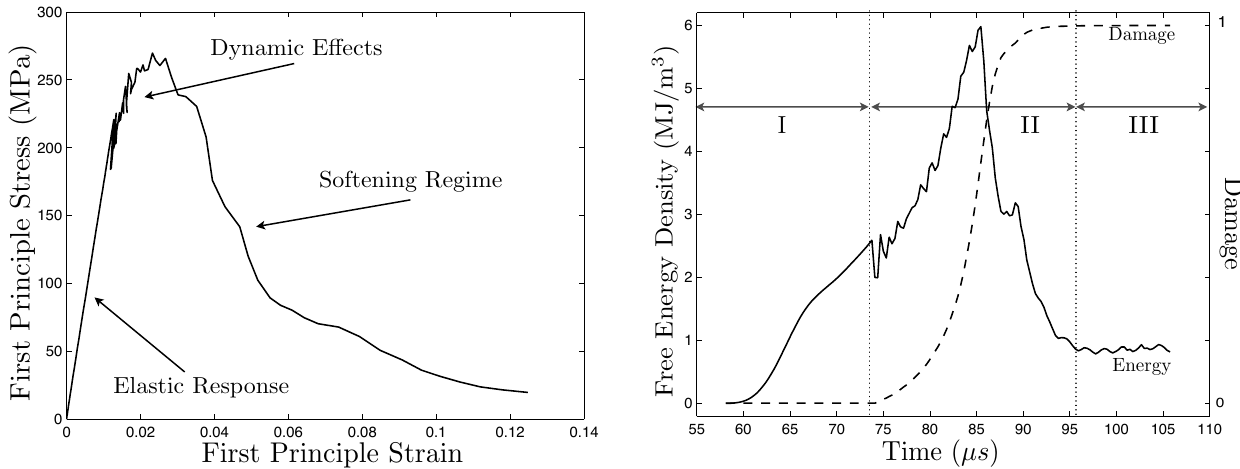
left cell in Figure 7. Note that both the parametric (in time) stress/strain plot and time series plot of the damage and energy are simply records of the motion of a point which becomes fully damaged, and are not comparable to the usual uniaxial stress strain